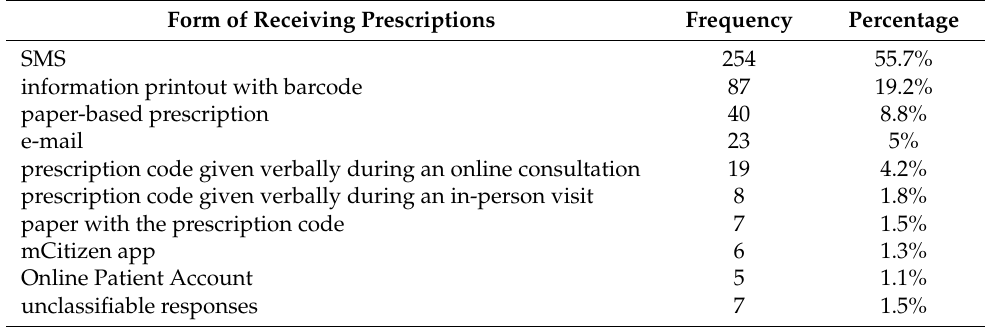
Table 6. Distribution of answers to the question about the most common form of receiving